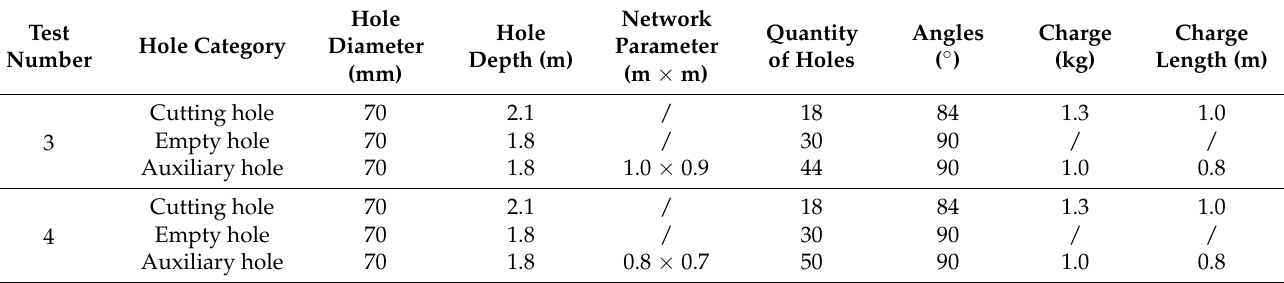
Table 3. Test parameters of upper step